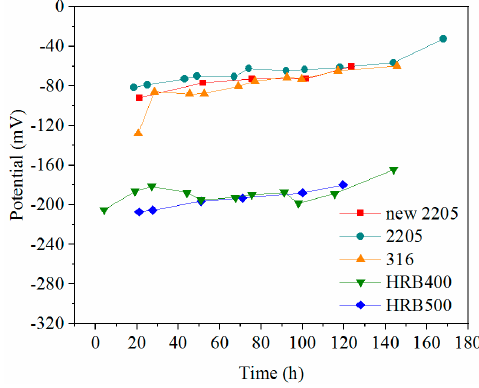
Figure 7. Natural corrosion potentials as a function of time.